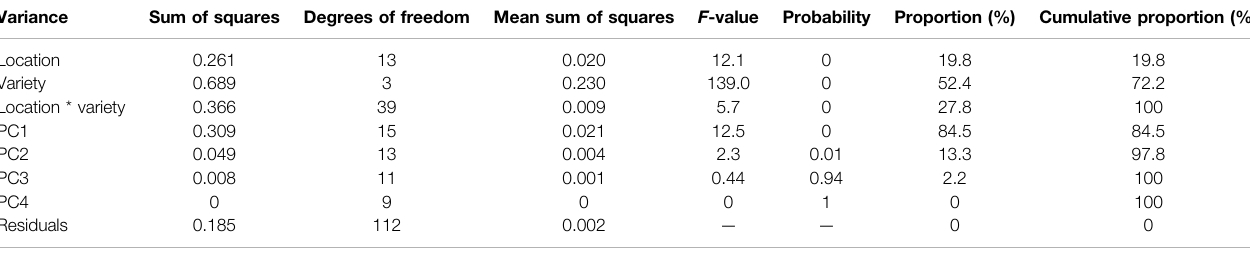
TABLE 3 | ANOVA for AMMI model and Gollob ’ s F -test for As content in grains for 4 varieties grown in 14 locations. Variance